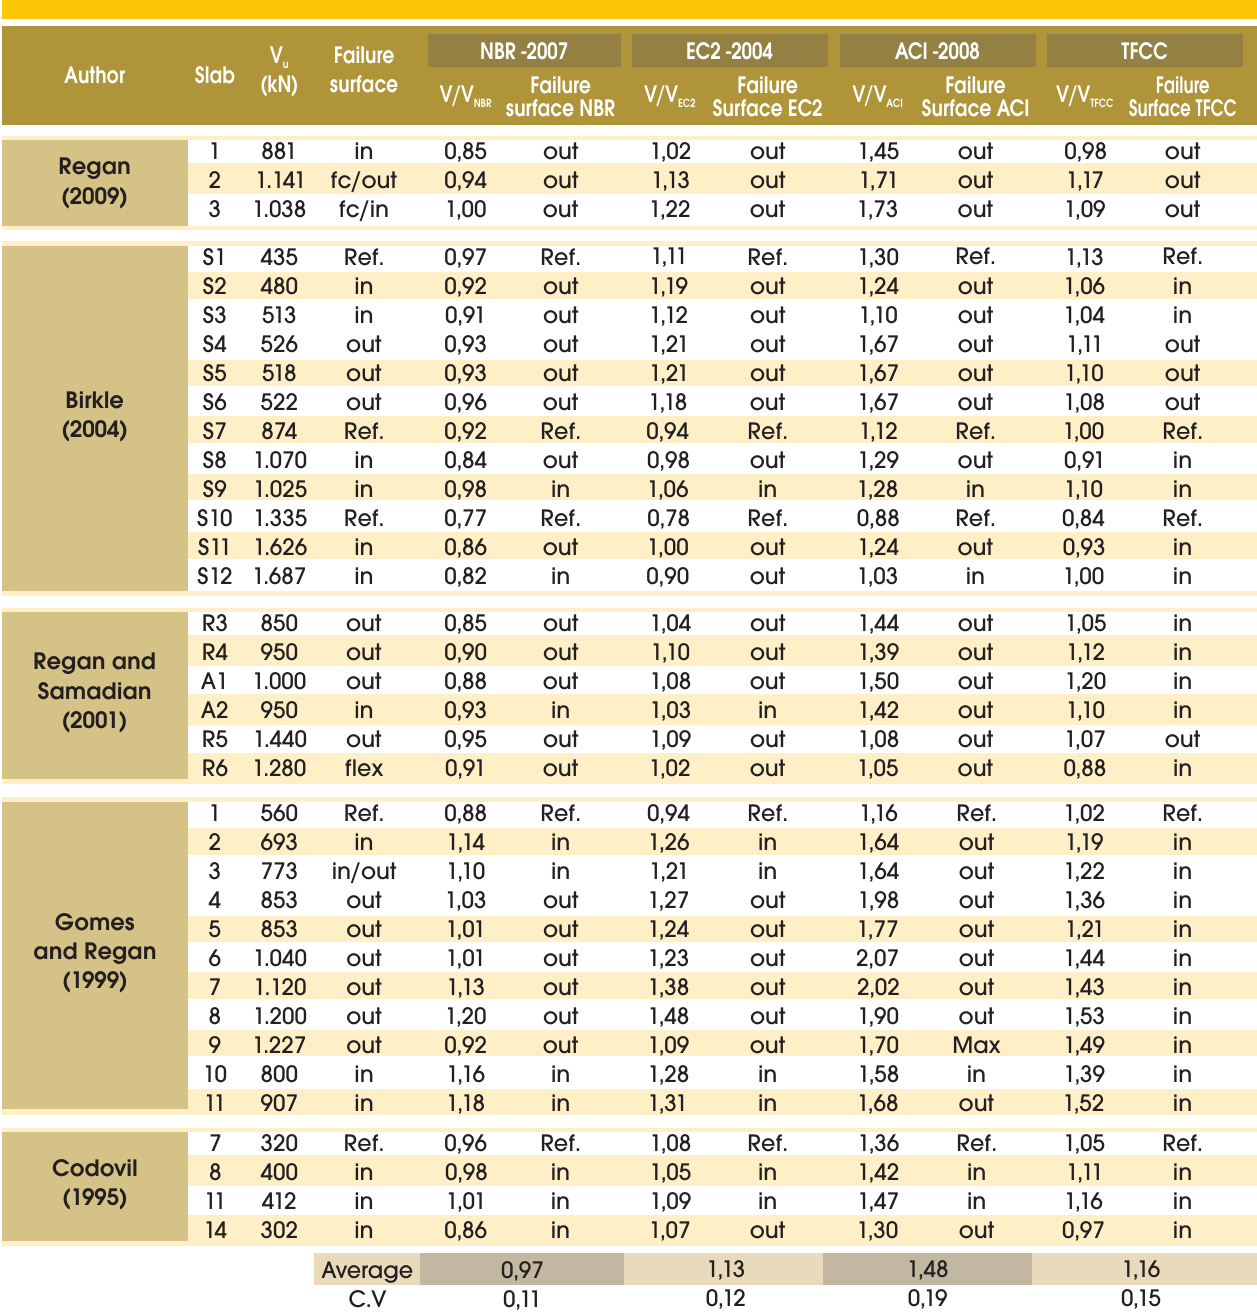
Table 4 – Relationship between the experimental results and theoretical